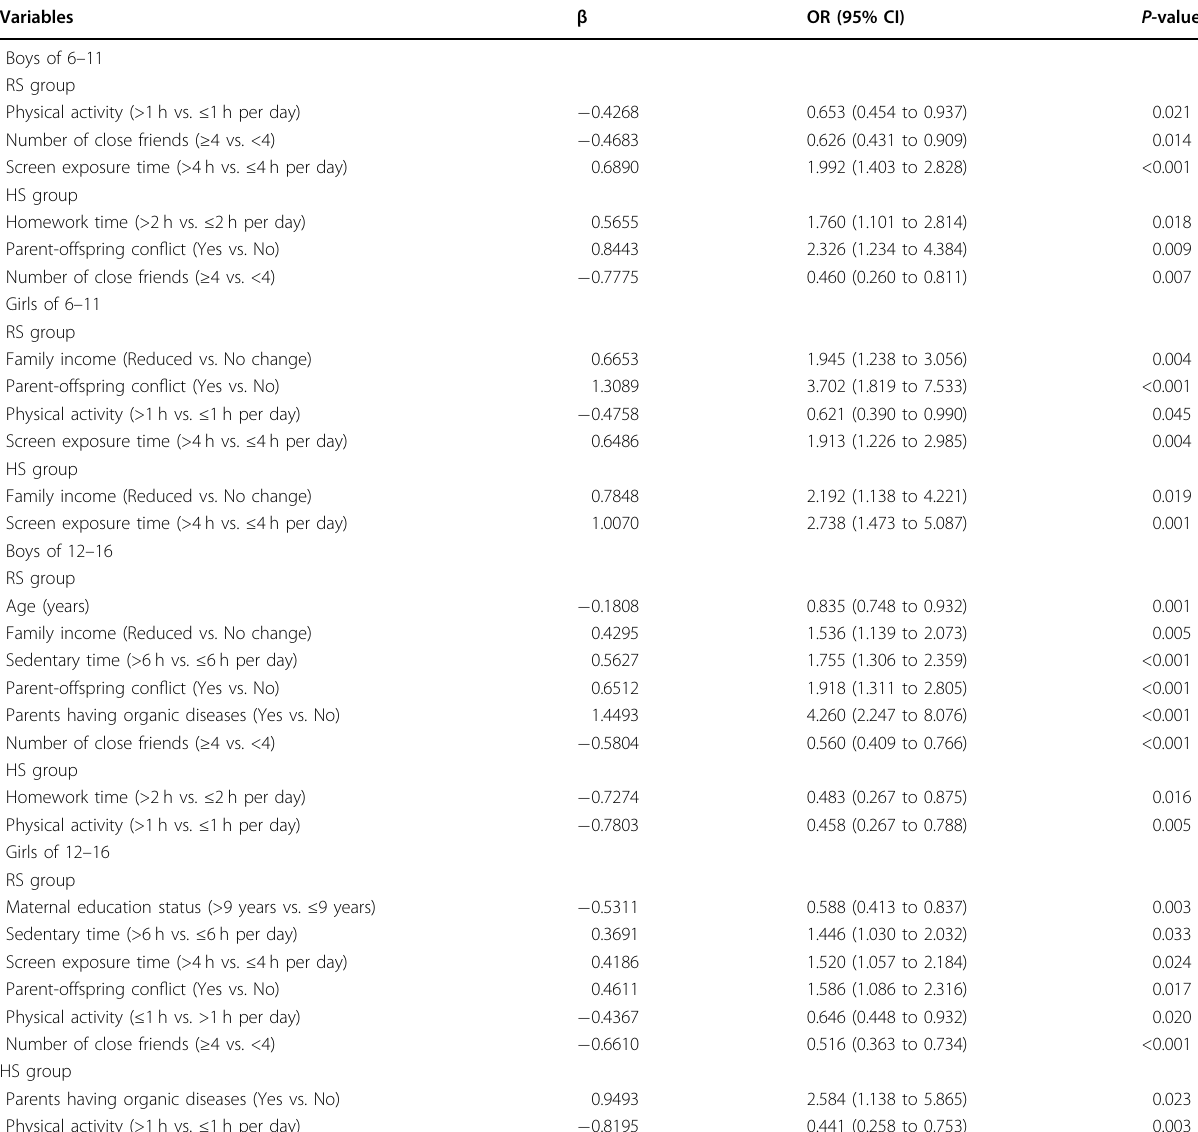
Table 4 Multivariate logistic regression analyses of psychosocial and behavioral problems and impact factors in different age and sex